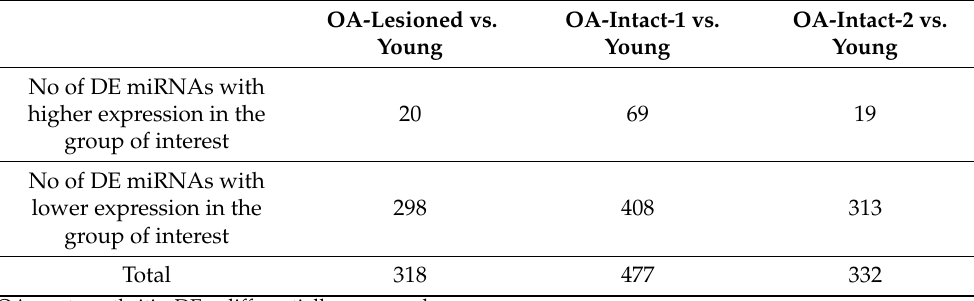
Table 1. Number of significant DE miRNAs in human cartilage samples. Significant DE miRNAs are defined as those with FDR-adjusted p -value < 5%. OA-Lesioned/OA-Intact 1/OA-Intact-2: group of interest. Young: reference group. OA-Lesioned vs.